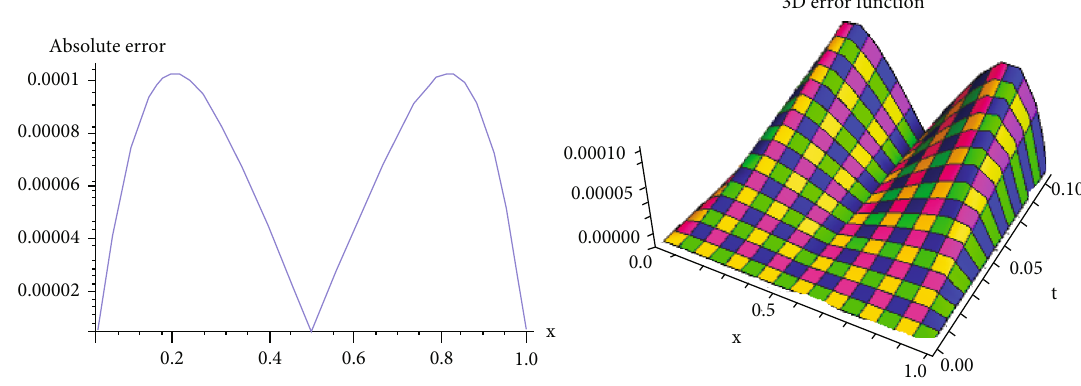
Figure 9: 2D and 3D error pro fi les for Example 7 when h = 1/60, t = 0 : 1, Δ t = 0 : 01